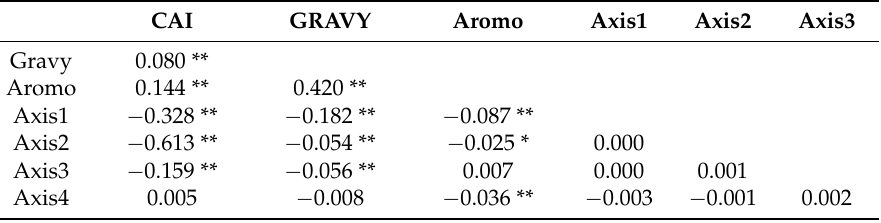
Table 3. Correlation coefficients between the positions of genes along the first four major axes with an index of total genes’ amino acid usage. CAI GRAVY Aromo Axis1 Axis2 Axis3 Gravy 0.080 **